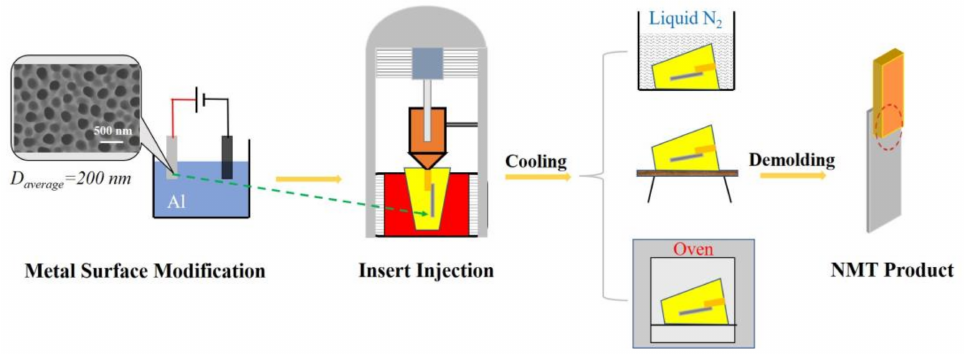
Figure 2. The main steps of nanomolding and corresponding NMT product. The left illustration is the SEM image of the aluminum sheet after surface modification, and more details of surface morphology can be found in Figure